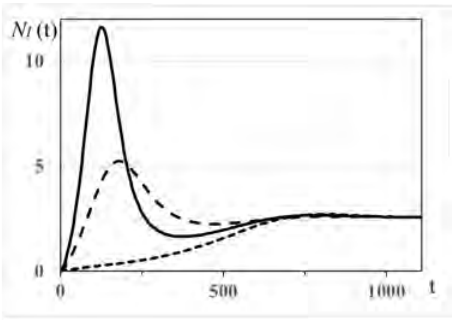
Fig. 9. Graphs of N I ( t ) for non-oscillating dynamics for 3 different initial values ϕ ( a ) .